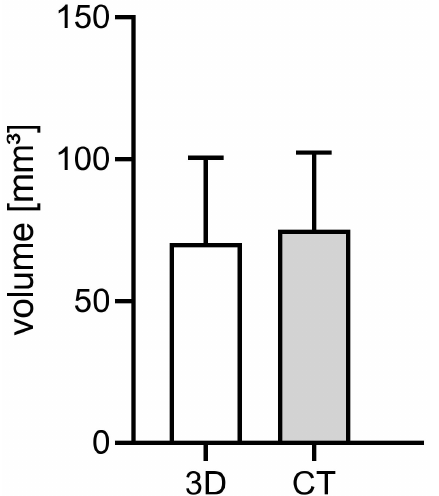
Figure 9. Comparison of ex ovo and in ovo measured volumetric data after engraftment. For a com- parison of the CT-based volume measurement method (grey bar) to the three-dimensional microscopic measurement method (white bar), data from three nephrectomies were evaluated ( n =